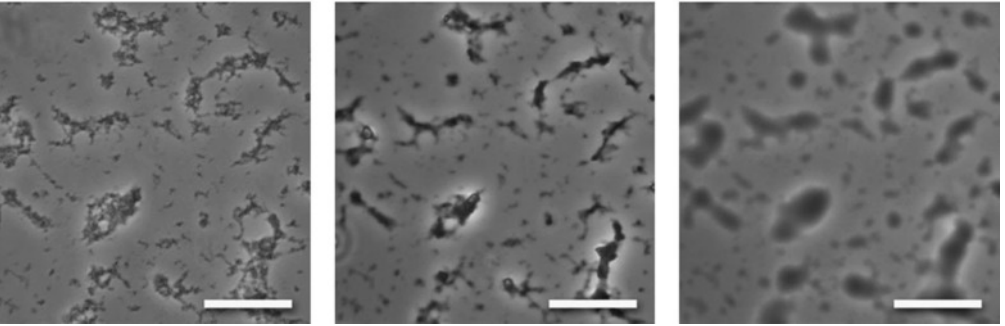
Figure 2. Optical micrographs showing the transition from solid precipitate to liquid coacervate for poly (L-lysine) and poly (L-glutamic acid) complexes with increasing urea concentration. Scale bars, 25 mm. Reprinted from Nature Communication, 2015, 6 , 6052. Copyright 2015 Nature Publishing Group.